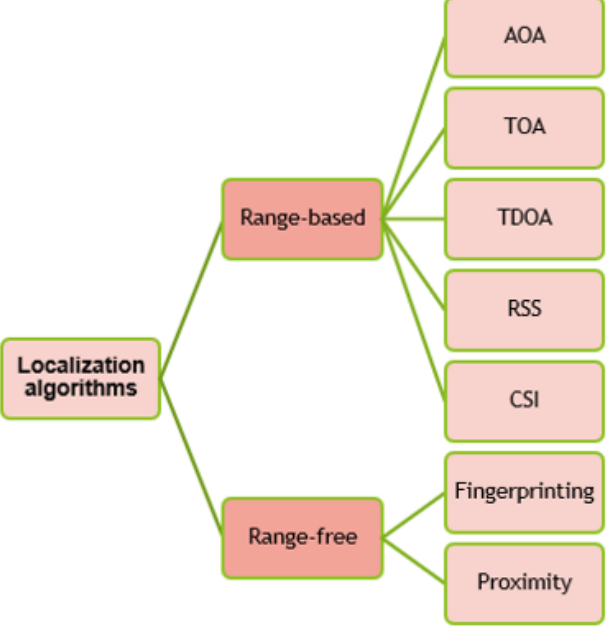
Figure 1. The position estimation methods between range-based and range-free